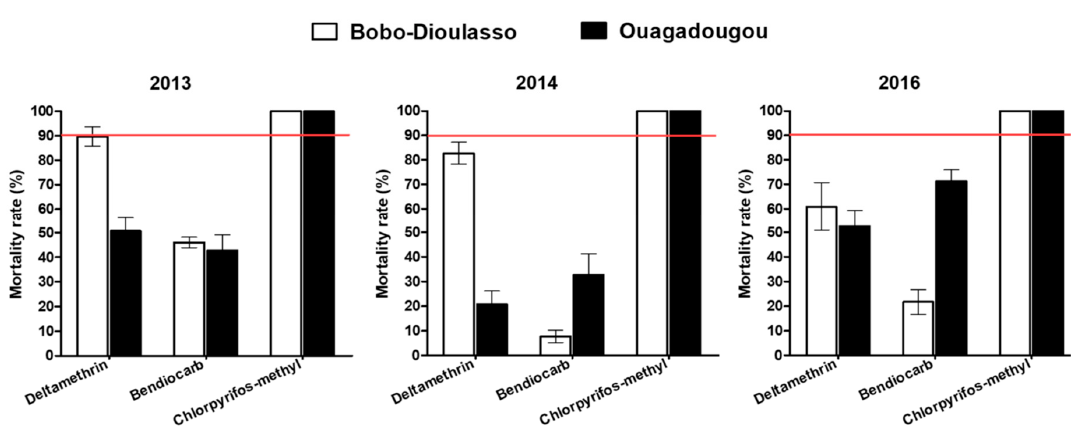
Figure 2. Mortality rates of the Aedes aegypti populations in Ouagadougou and Bobo-Dioulasso during the three years of survey. Red bars indicate the threshold of susceptibility.